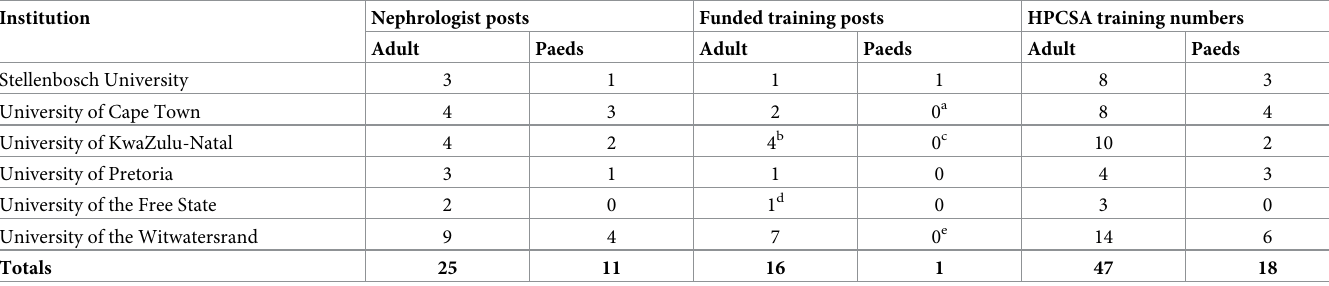
Table 2. Training capacity for adult and paediatric nephrologists in South Africa.